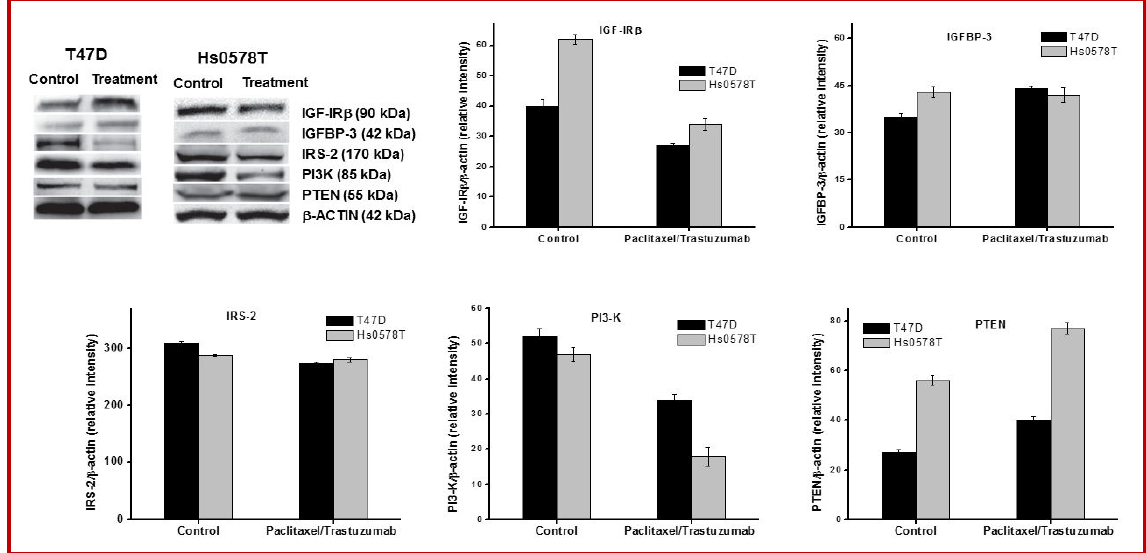
Figure 1: Effect of paclitaxel and trastuzumab on protein expression of downstream signaling molecules in IGF mediated cell proliferation in T47D and Hs0578T cells by Western